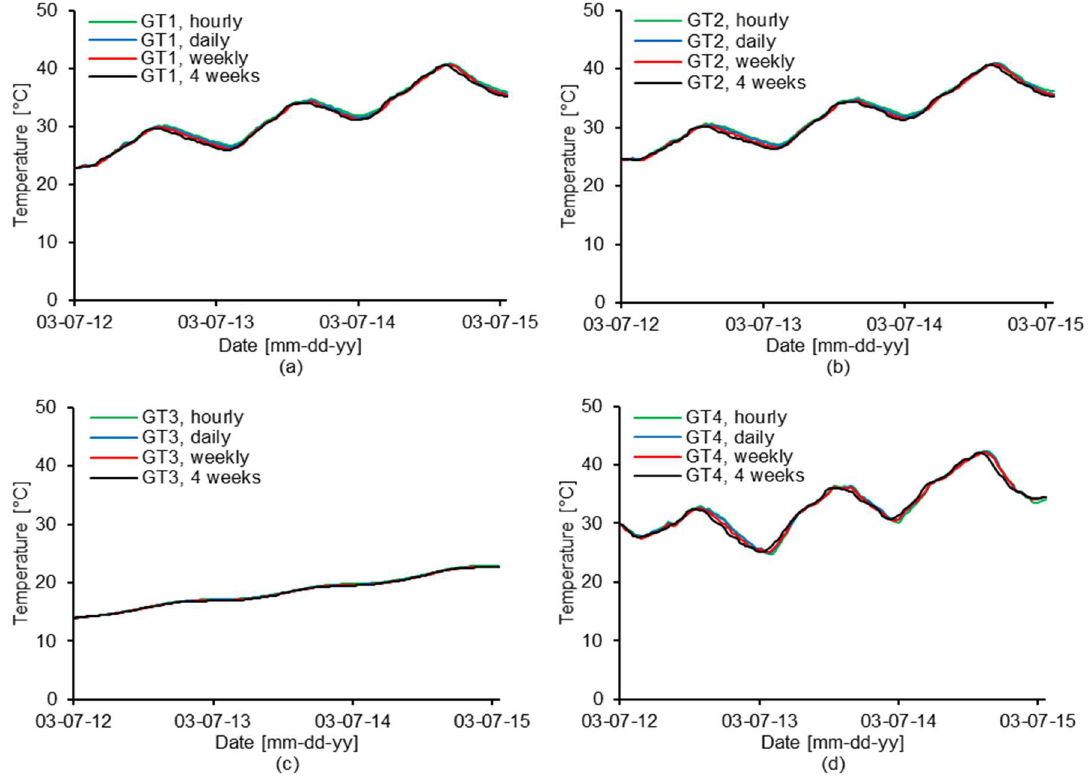
Figure 11. Calculated ground temperatures, ( a ) GT1, ( b ) GT2, ( c ) GT3 and ( d ) GT4, for different time steps.